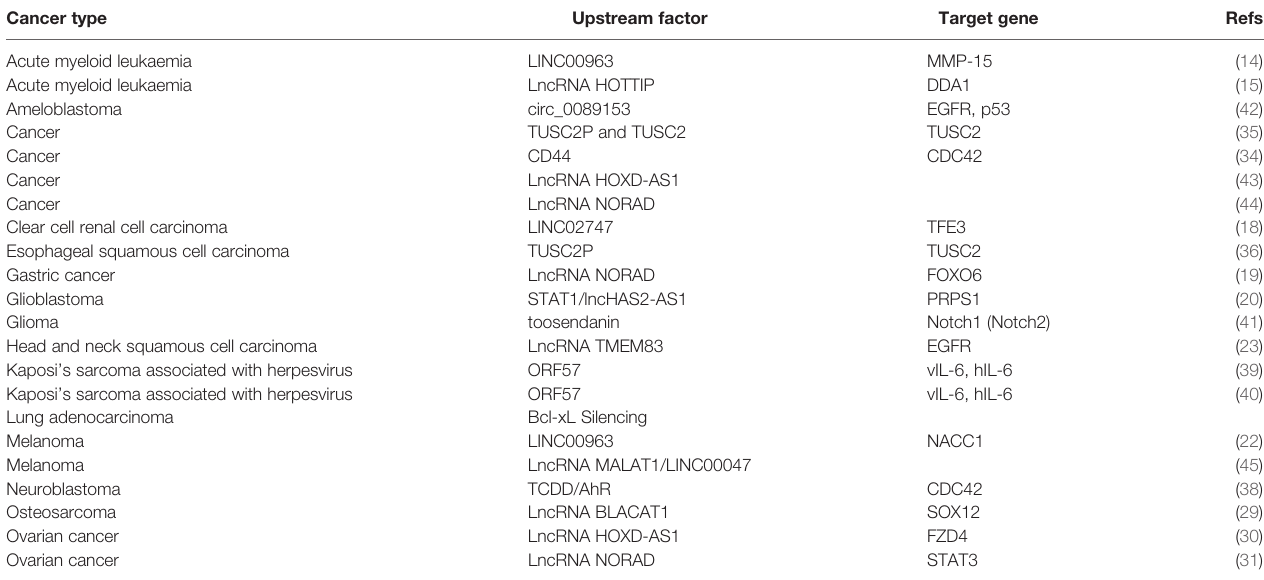
TABLE 1 | The upstream and target genes of miR-608 in multiple